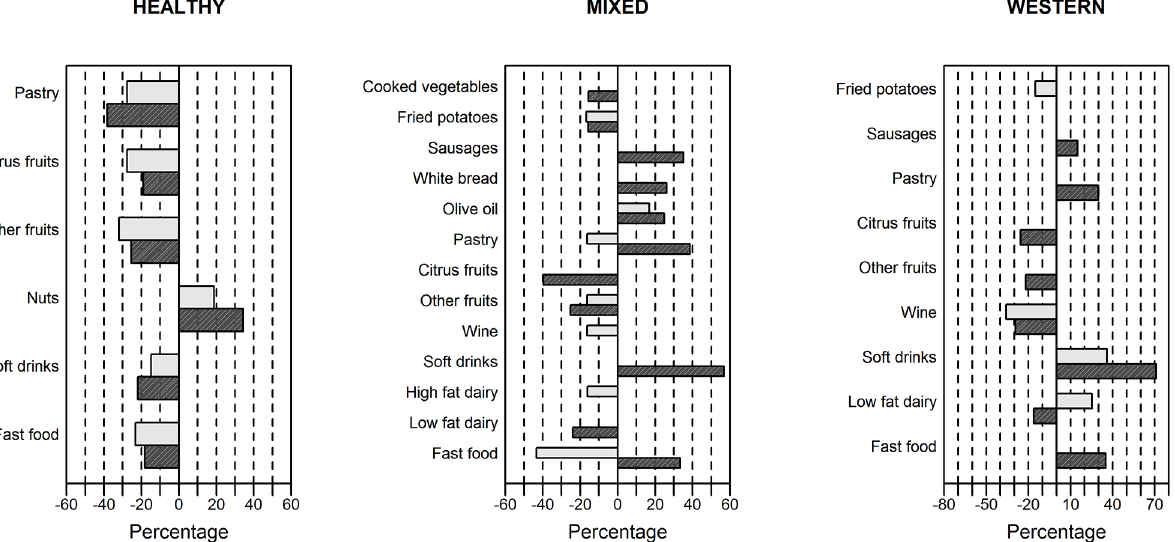
Fig 2. Meaningful * percentage temporal changes in absolute intake of food group consumption in grams of secular trends in all reporters and plausible energy reporters in the 1) “ healthy ” , 2) “ mixed ” and 3) “ western ” patterns. Only groups of food are included, which had meaningful changes. The analysis was unadjusted for population differences between the two surveys in age, sex, smoking and physical activity. The unhealthy perceived food groups go first, the healthy food groups are in continuation. A positive value means an increase from the REGICOR 2000 to the REGICOR 2005 and a negative value means a decrease from the REGICOR 2000 to the REGICOR 2005. White — all reporters, black — plausible energy reporters. * (cid:1) 15% change in food group consumption compared between the REGICOR 2000 and the REGICOR 2005